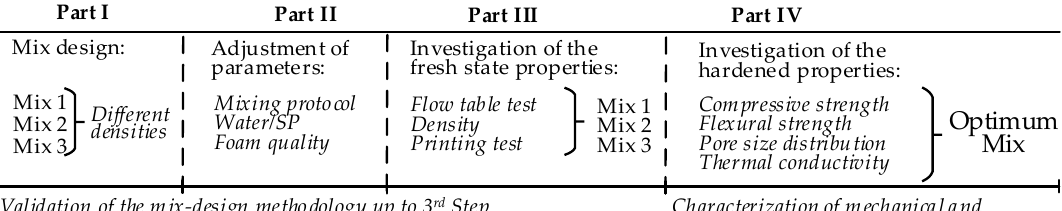
Figure 1. Overview of the experimental program.